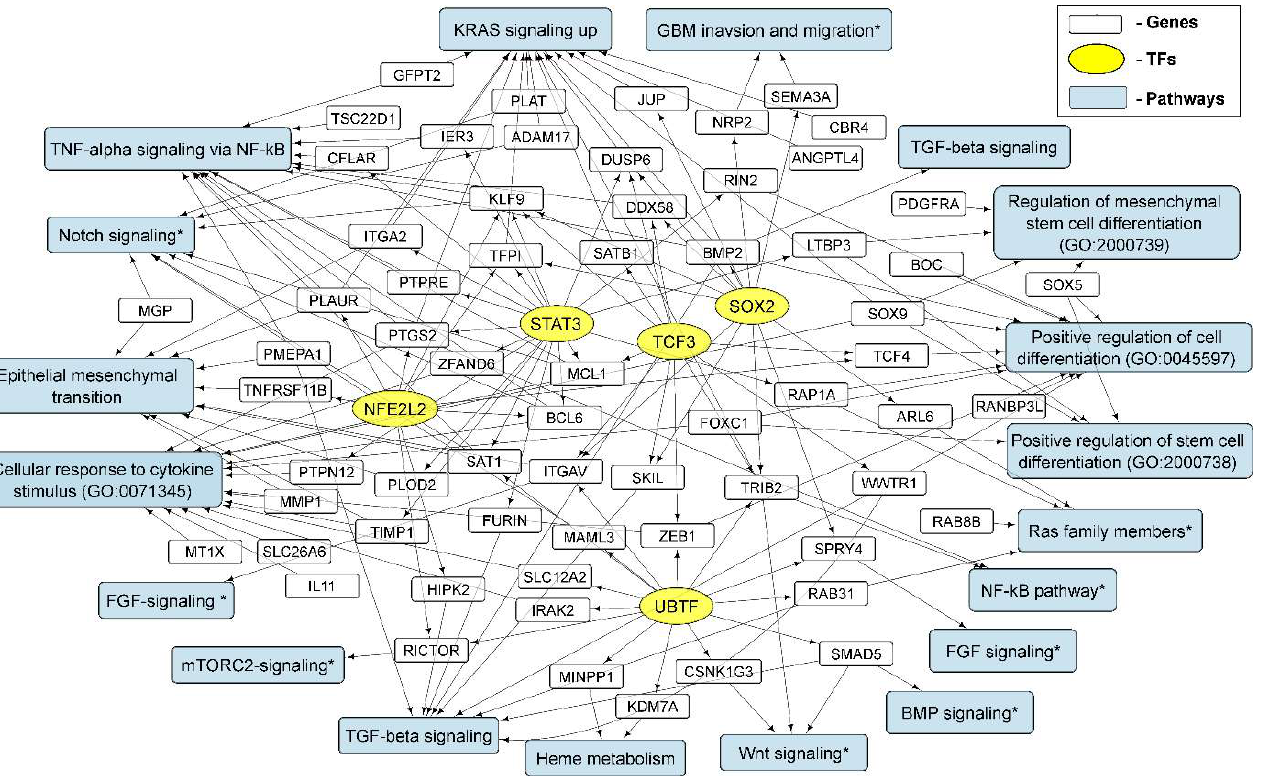
Figure 6. The relationship between the activation of transcription factors SOX2, UBTF, NFE2L2, TCF3 and STAT3; individual activated genes and signaling pathways; and biological processes characteristic of the formation of NS glioma cells. The results of the analysis of gene sets using the Enrichr “GO Biologic Process 2021” and “KEGG_2021_Human” libraries are summarized with the addition of recently published data presented in the text (marked with *).